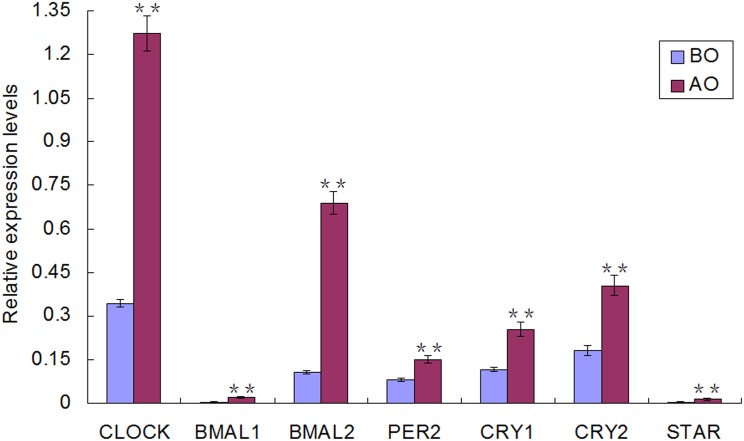
qRT- PCR validation of putative target genes.Mean expression levels were normalized to GAPDH controls, error bars show standard errors for replicates (n = 3). **means a statistically significant difference (P < 0.01). BO, before onset of the rapid gonad development; AO, after onset of the rapid gonad development.